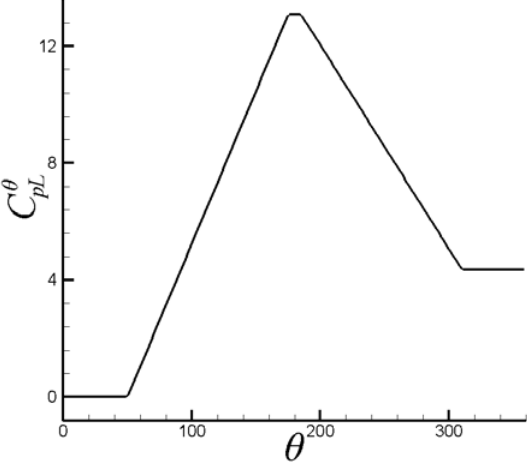
θ C with the asymmetric Lorentz force (upper pW